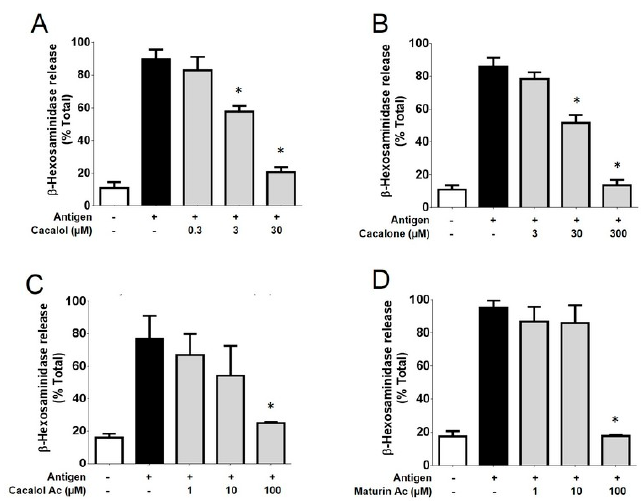
Figure 2. Cacalolides inhibit degranulation stimulated by antigen in bone marrow-derived mast cells. Effect of cacalol ( A ) cacalone ( B ) cacalol acetate ( C ) and maturine acetate ( D ) pre-treatment on DNP-HSA-induced degranulation, n = 3. * p ≤ 0.05.